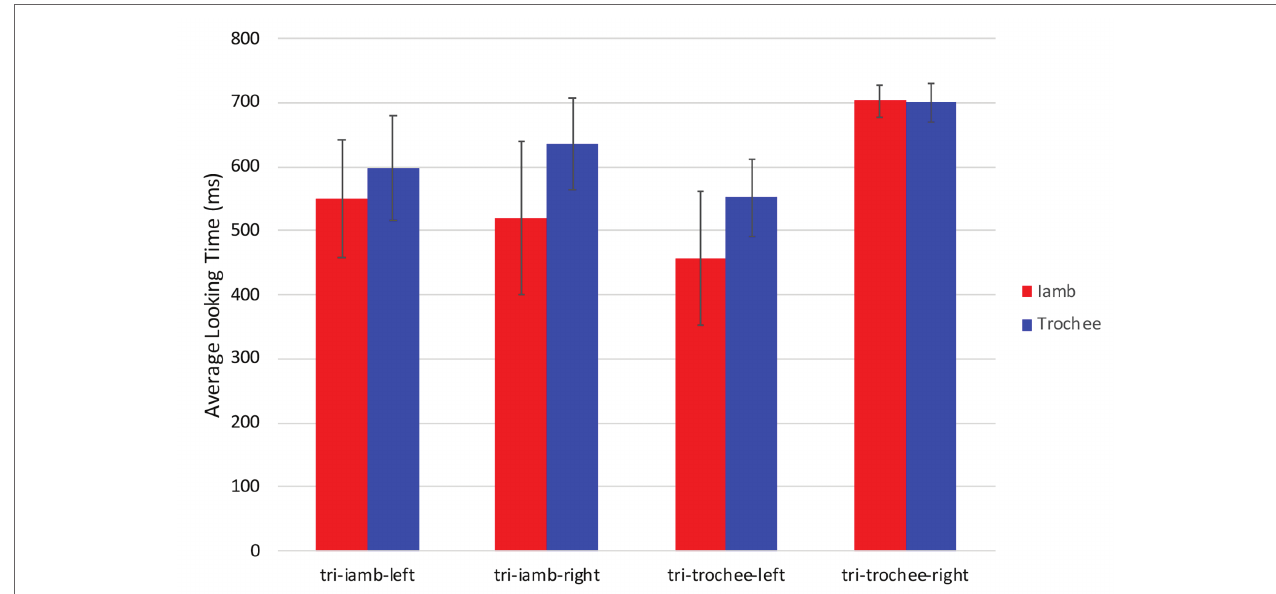
FIGURE 4 | Average looking times (in milliseconds) during the training phase, considering side and image. Error bars indicate the standard error of the mean (±1).